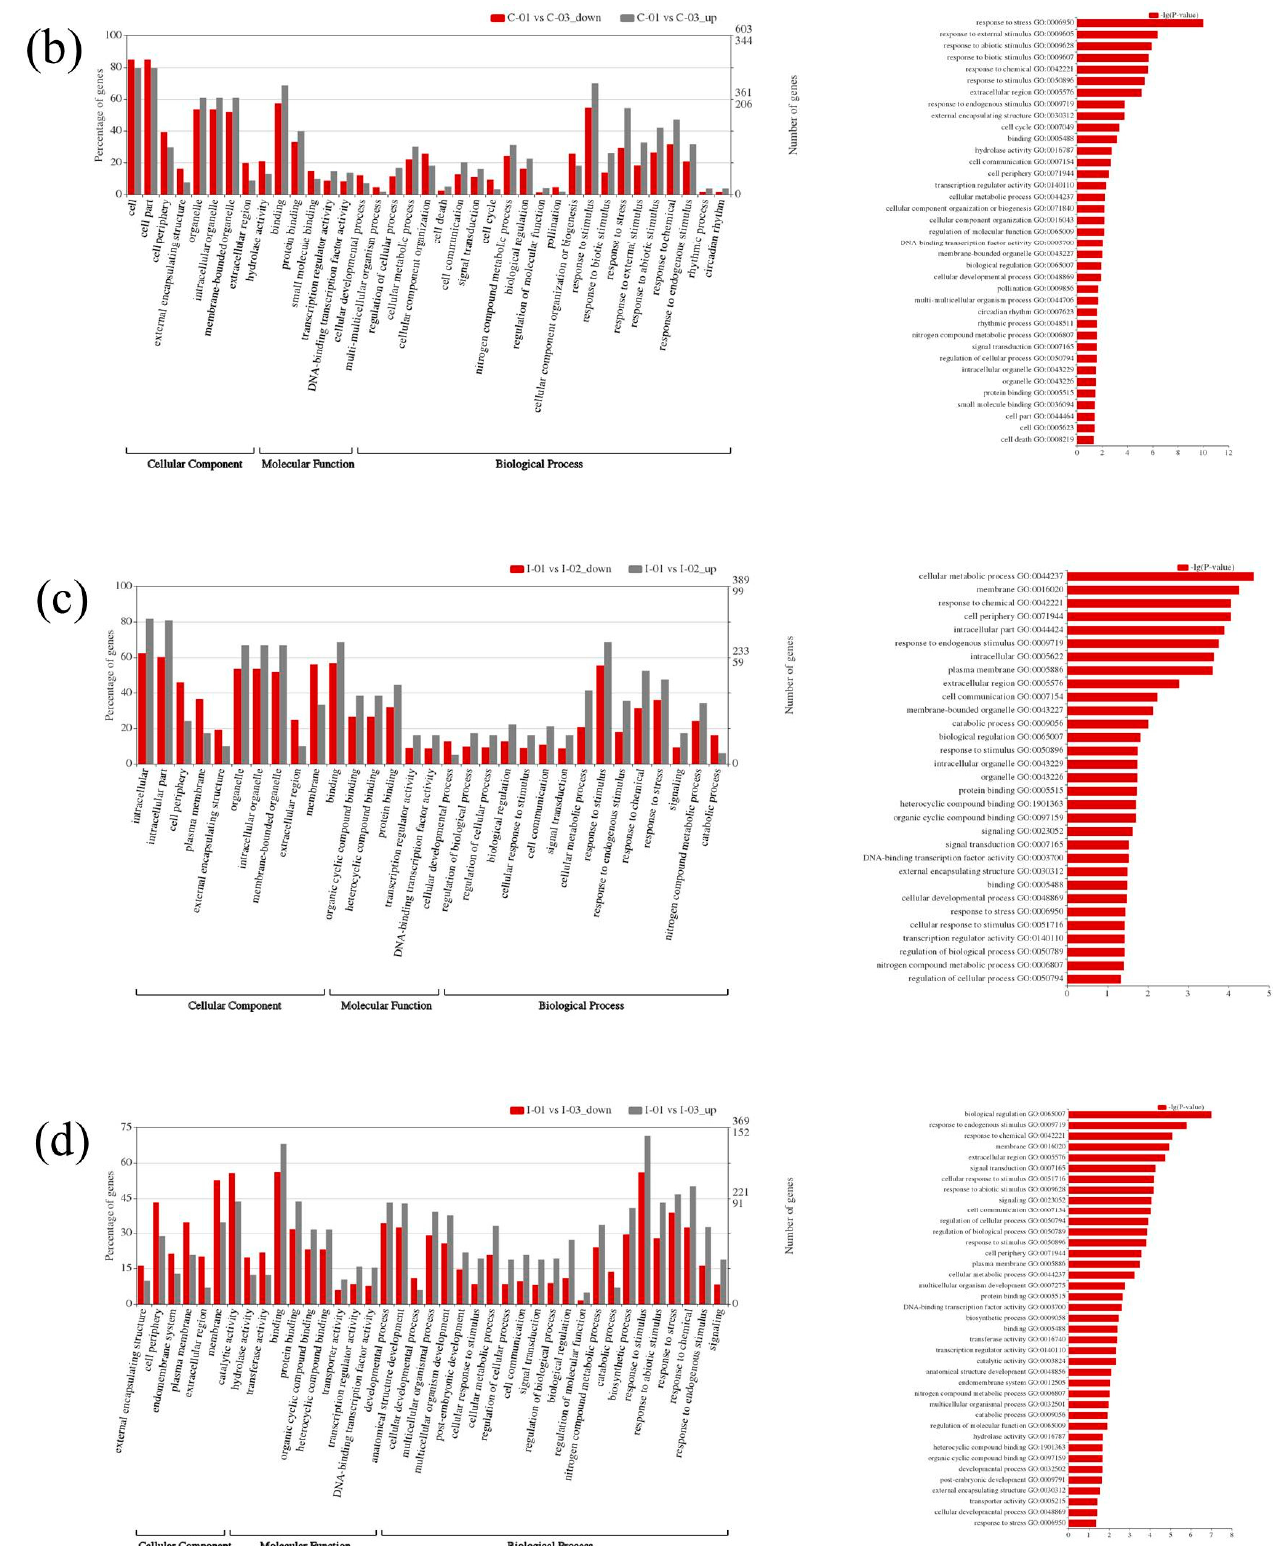
Figure 6. Gene Ontology (GO) enrichment analysis of DEGs. ( a , b ) Clivus; ( c , d ) I-476. Grey and red represent the upregulated and downregulated DEGs, respectively.